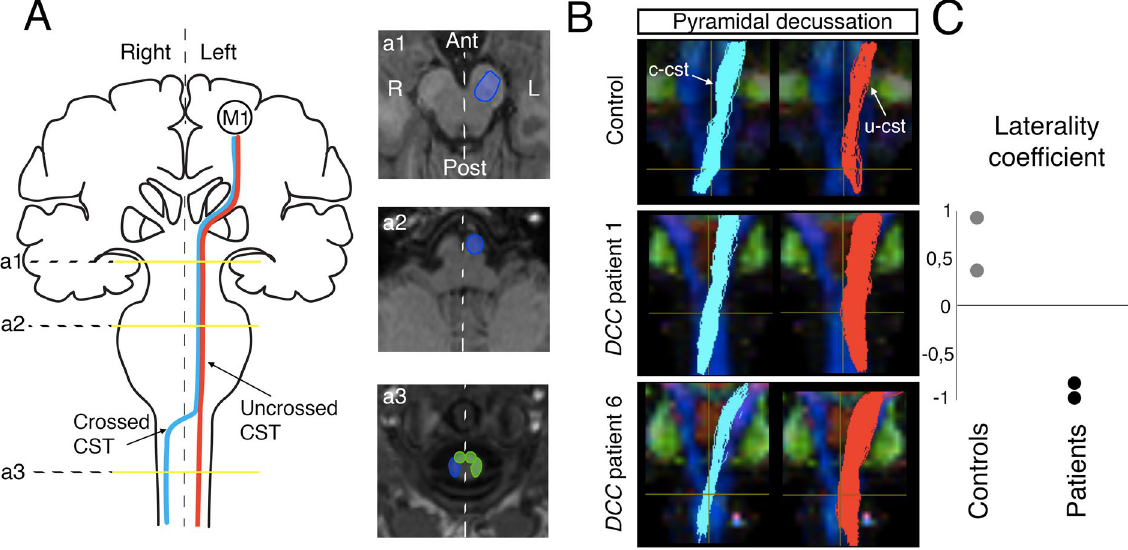
Figure 2. Tractography of the CST in DCC -CMM patients. ( A ) Left: color coding of the crossed (blue) and uncrossed (red) corticospinal tracts; Right: regions of interest (both in the diagram and superimposed on an axial slice of an anatomical image of a subject) used to reconstruct the fiber tracts (blue area) at the base of the pons (a1), the anterior pyramid in the upper medulla (a2), and the crossed lateral funiculus of the upper cervical cord (a3). The crossed CST from the left M1 to the right upper cervical cord was reconstructed after excluding fibers reaching the right medial and left lateral and medial funiculi (green area). ( B ) Tractography of the corticospinal tract superimposed on the individual fractional anisotropy color map of a control subject and two DCC -CMM patients. Individual coronal views at the level of the decussation are presented. Light blue tracts represent the crossed CST, and red tracts the uncrossed CST. ( C ) The corticospinal tract laterality coefficient is expressed as (NF Crossed − NF Uncrossed)/(NF Crossed + NF Uncrossed), where NF is the number of fibers. The coefficient was positive for the two controls (indicating more fibers in the crossed corticospinal tract) and negative for the two DCC -CMM patients (indicating more fibers in the uncrossed corticospinal